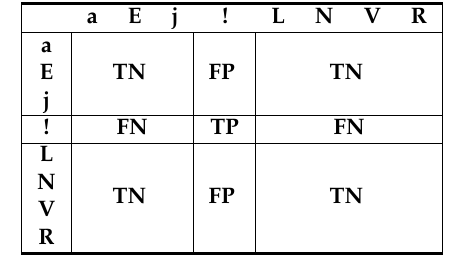
Table 10. Examples of how to compute TP, TN, FP, and FN of class “!”.